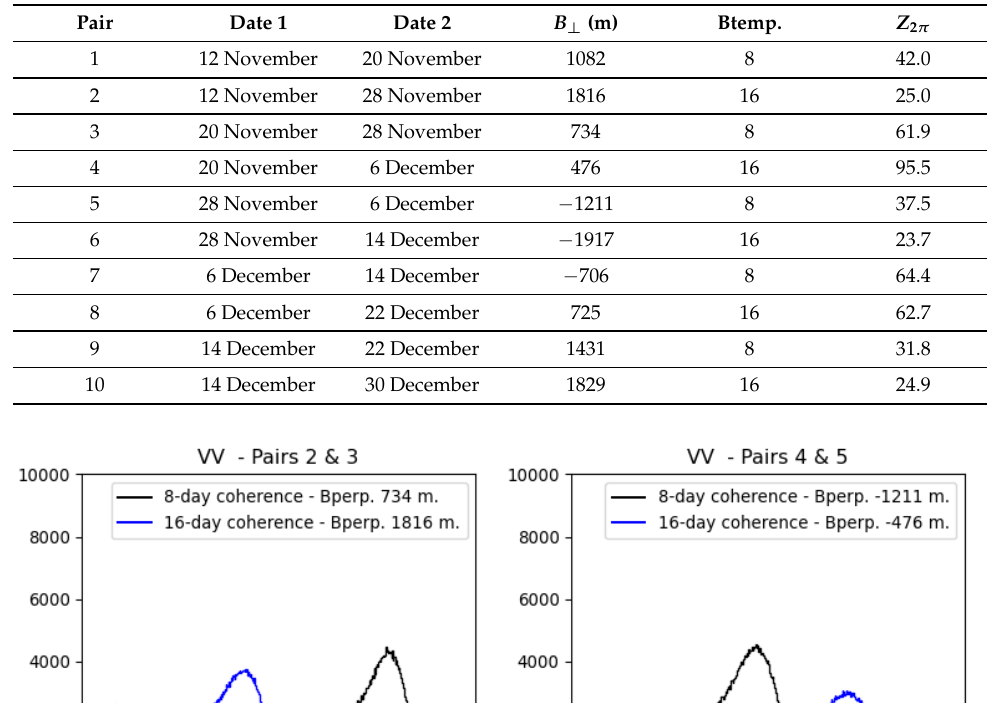
Table 2. 8 and 16-day interferometric pairs used to compare | γ | formed with the SAO1-A and SAO1-B ascending images.